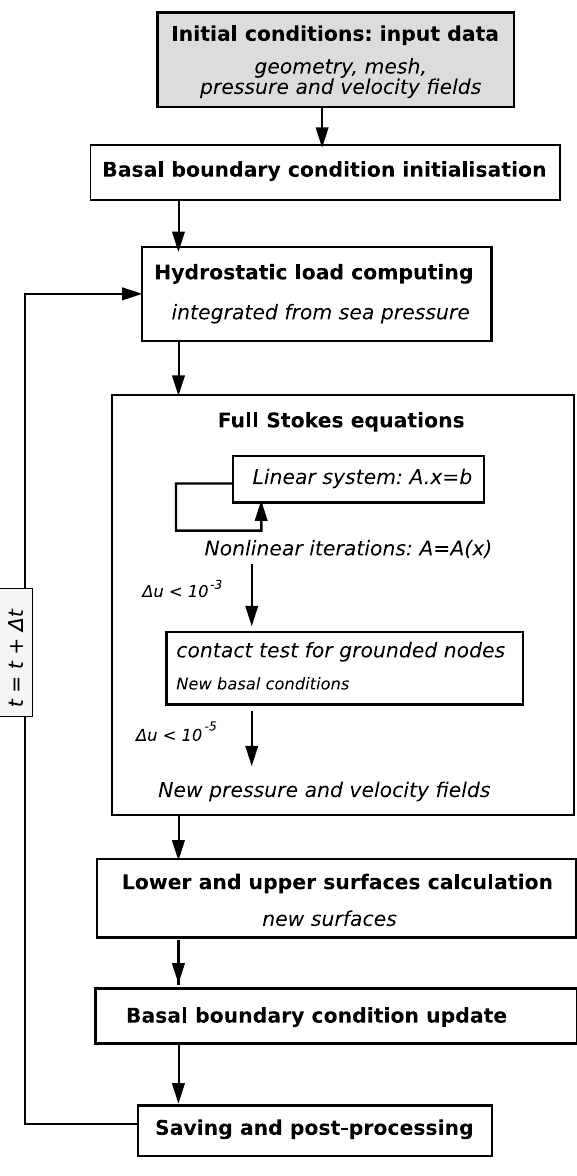
Fig. 2. Simplified algorithm of the